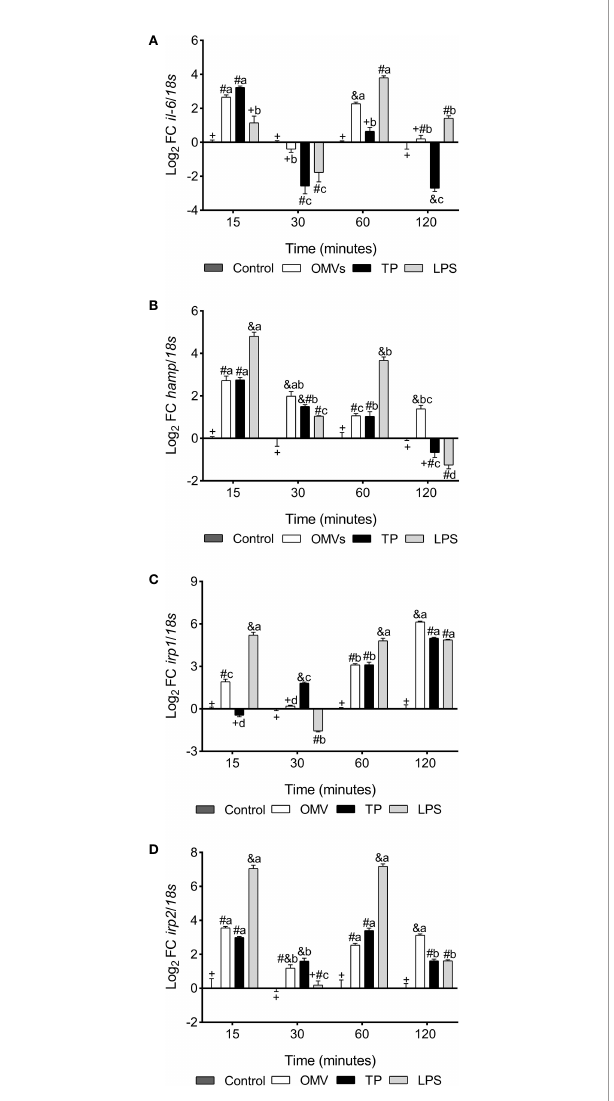
FIGURE 4 | Transcription of il-6 (A) , hamp (B) , irp1 (C) and irp2 (D) in SHK- 1 cell line stimulated with 1 m g each PAMPs of P. salmonis at 15-, 30-, 60- and 120-minutes post-stimulation. Expression analysis of mRNA was performed by qPCR and 18s was used for normalization. Symbols over the bars indicate statistical differences between the different treatments at the same time points. Different letters indicate statistical differences in the same treatment at different times. Two-way ANOVA, p < 0.05;